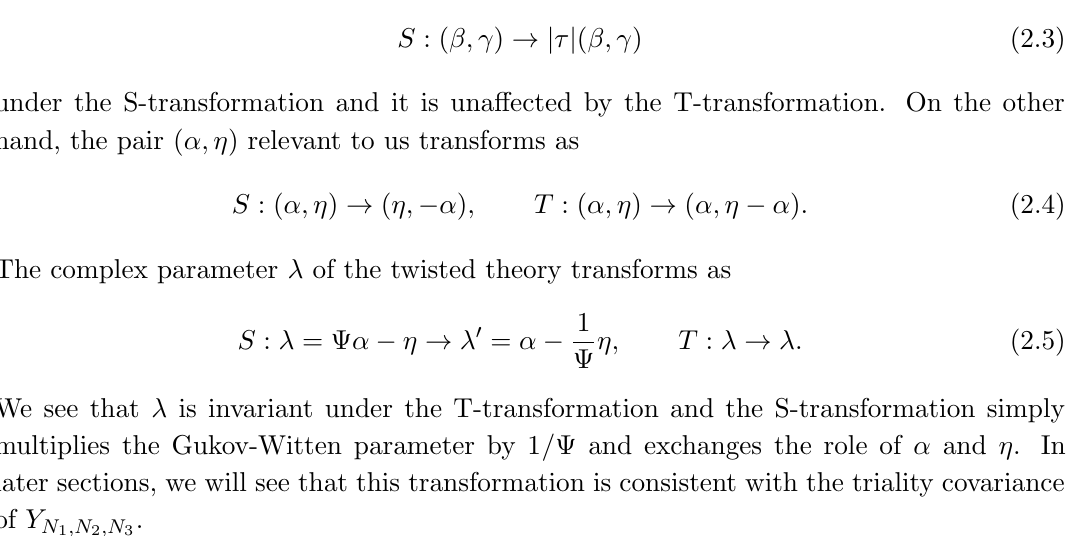
Figure 2. Line operators M i at interfaces and give rise to degenerate modules of VOA. GW defects attached to the corners of the diagram are labeled by (cid:21) (1) (cid:9) and give rise to generic